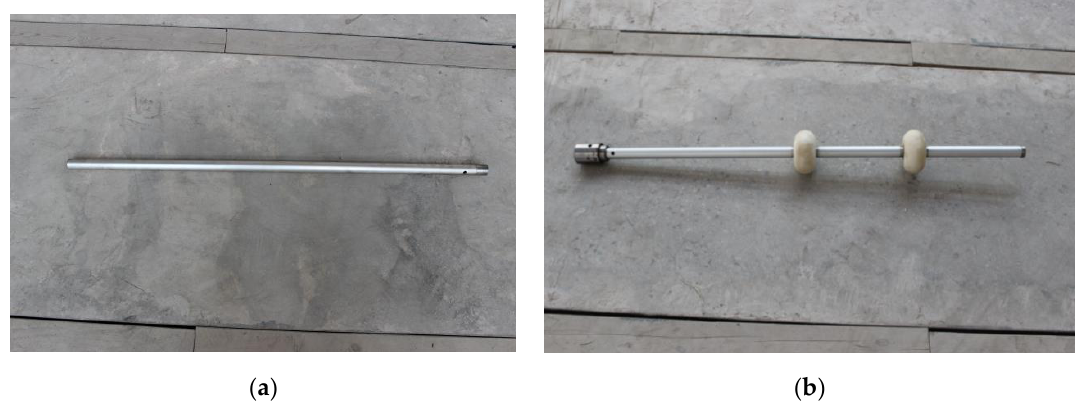
Figure 7. Typical pile structure: ( a ) P-1 equal-section pile; and ( b ) P-7 nodular pile.